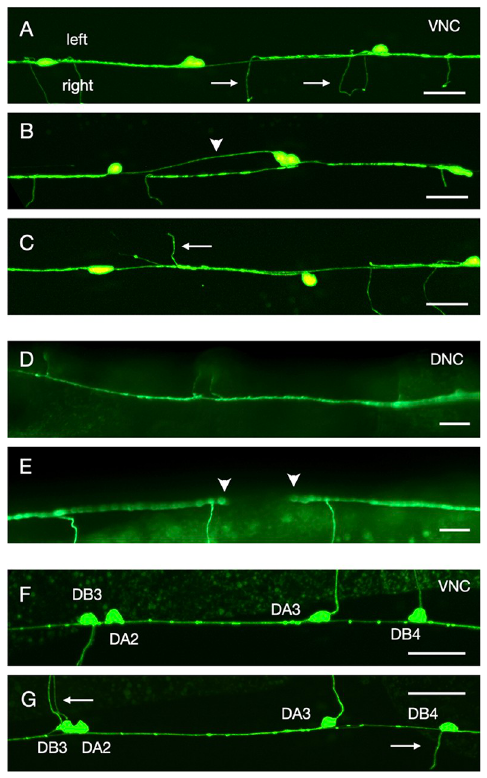
Fig 4. Motoneuron defects in lron-11 mutants. Panels A, D and F show wildtype, panels B, C, E and G show lron-11 mutants. The anterior side of the animals are towards the left of the image, the left side of the animals is towards the top of the image. Scale bars: 20 μ m. A-C: VNC visualized with the DD/VD motoneuron marker oxIs12[unc-47 :: GFP)] . A) In wildtype DD/VD neurites are in the right axon tract and commissures extend on the right side (arrows). B) In lron-11(ok2333) mutant animals some axons extend in the left axon tract (arrowhead). C) In lron-11(ok2333) mutant animals some commissures extend on the left side (arrow). D, E: DNC visualized with the DD/VD motoneuron marker oxIs12[unc-47 :: GFP)] . D) In wildtype animals motoneuron axons cover the entire DNC without gaps. E) Some lron-11(ok2333) mutant animals show gaps in the DNC (arrowheads). F-G: VNC visualized with the DA/DB motoneuron marker evIs82A[unc-129 :: GFP] . The images contain the region covering the neurons DB3, DA2, DA3 and DB4 in order, from left to right. F) In wildtype animals DB3 and DA2 send commissures to the right side, whereas DA3 and DB4 send their commissures to the left side. G) In this lron-11 ( ok2333 ) mutant animal, the DB3, DA2 and DB4 commissures extend on the wrong side